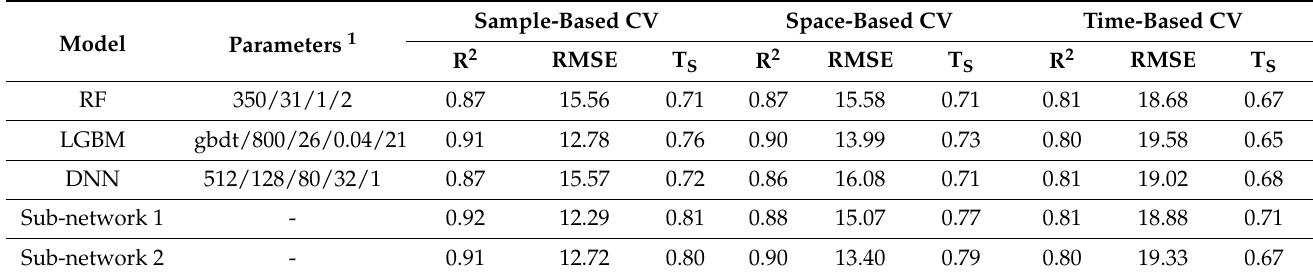
Table 1. Statistical metrics of models’ CV